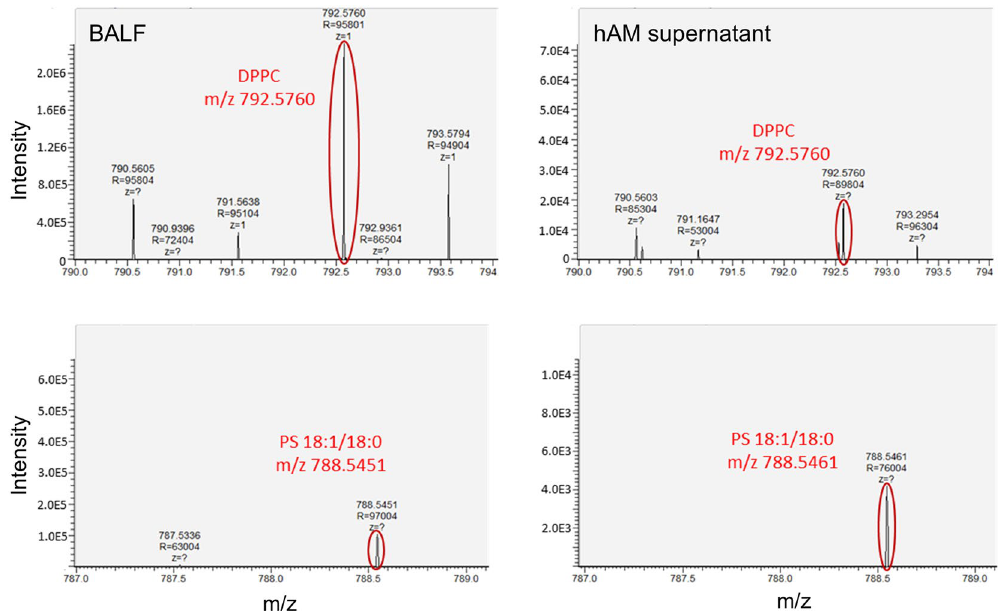
Figure 5. Lipidome analysis of hAM supernatant. Comparison of lipid species between porcine BALF (left) and hAM secretome (right) reveals secretion of the main PS-associated lipids by both subregions of hAM. Among others, dipalmityolphosphatidylcholine (DPPC, top) and phosphatidylserine (PS [18:1/18:0]), bottom) were detected. Illustrated are representative mass spectra supernatants of porcine BALF (left) and hAM supernatant (right) as analysed by